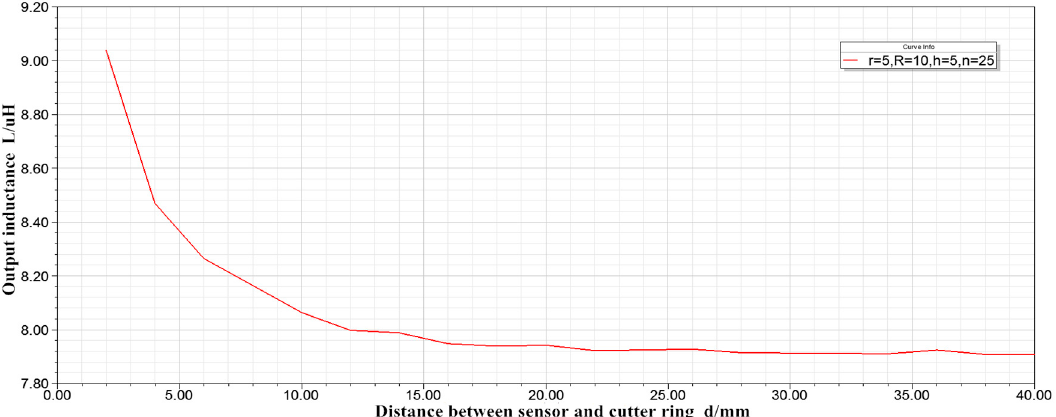
Figure 5. Characteristic curve of inductance displacement.